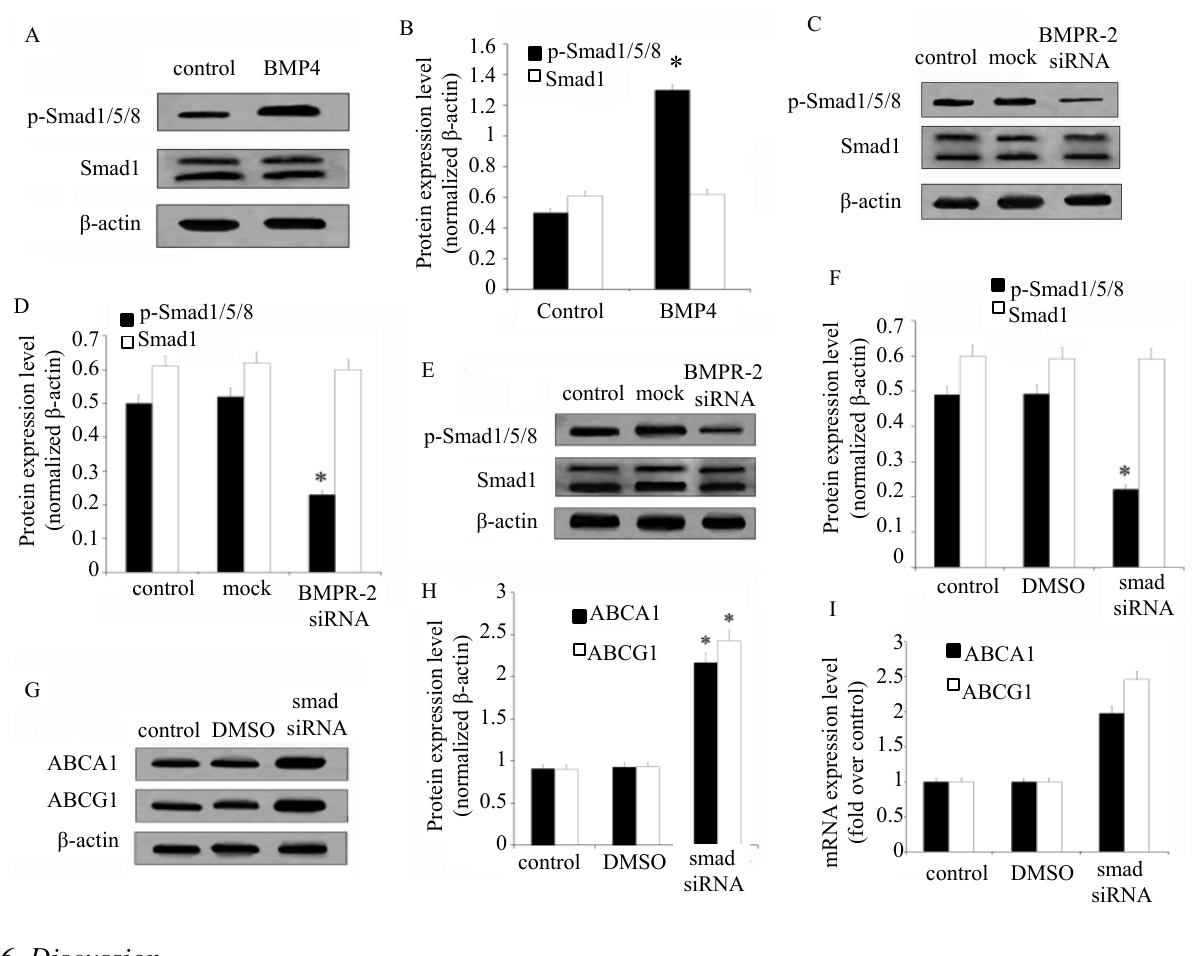
Figure 5. BMP4 induces foam cell formation by BMPR-2/Smad1/5/8 signaling. Unless otherwise specified, macrophages of murine RAW264.7 cell line below were cultured in DMEM with oxLDL. After treatment with PBS (control) or BMP4, macrophages were cultured for 48 h. Then the expression of p-Smad1/5/8 and Smad1 were evaluated using Western blot ( A ) and quantified with relative densitometry over β-actin ( B ). Then, macrophages were treated with PBS (control), mock, or BMPR-2 siRNA, the expression of BMPR-2 in macrophages were evaluated using Western blots ( C ) and quantified with relative densitometry ( D ). In addition that the macrophages were treated with PBS (control), DMSO, or Smad siRNA, p-Smad1/5/8 and Smad1 were evaluated using Western blot ( E ) and quantified with relative densitometry over β-actin ( F ), then the ABCA1 and ABCG1 expression were evaluated using Western blots ( G ) and its relative quantification over β-actin ( H ) and RT-PCR ( I ). * p <